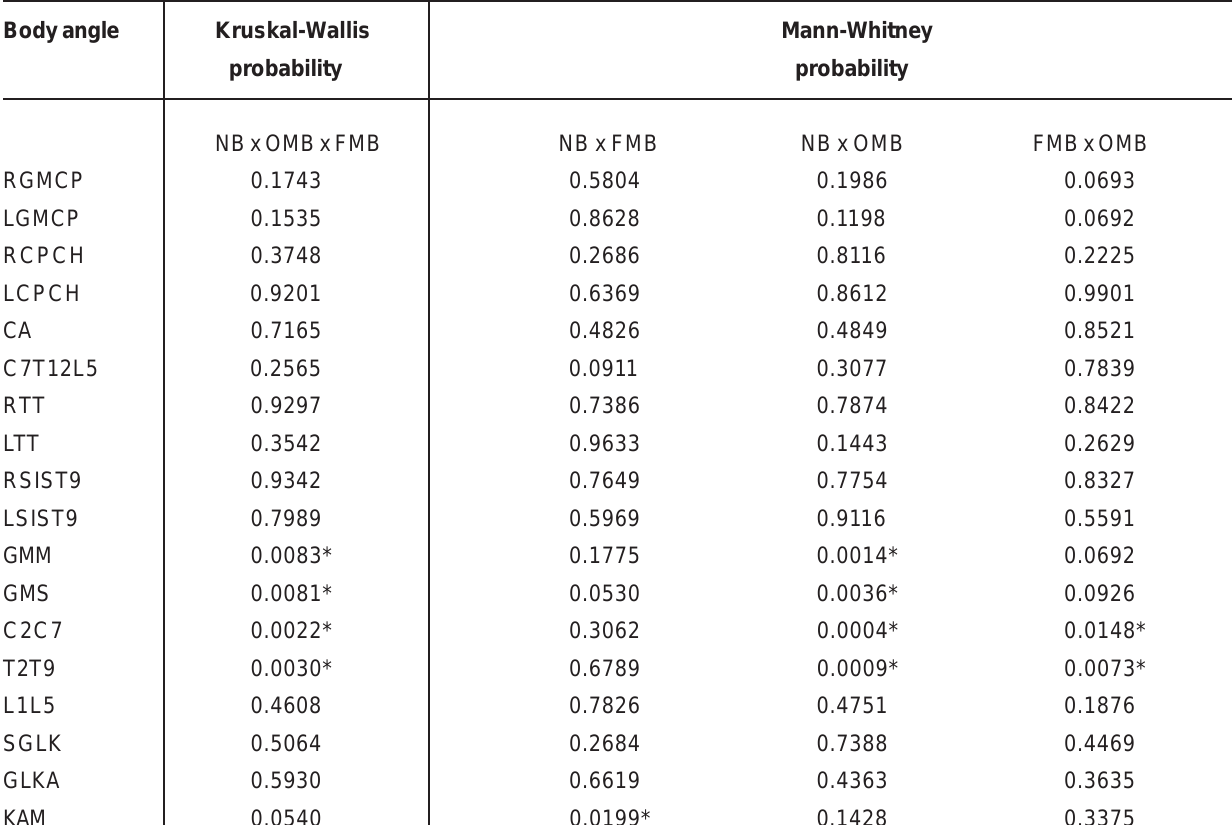
TABLE 1 - Mean body angles (degrees) obtained for children with obstructive (OMB) and functional mouth breathing (FMB) and children with nasal breathing (NB) analyzed by the Kruskal-Wallis and Mann-Whitney